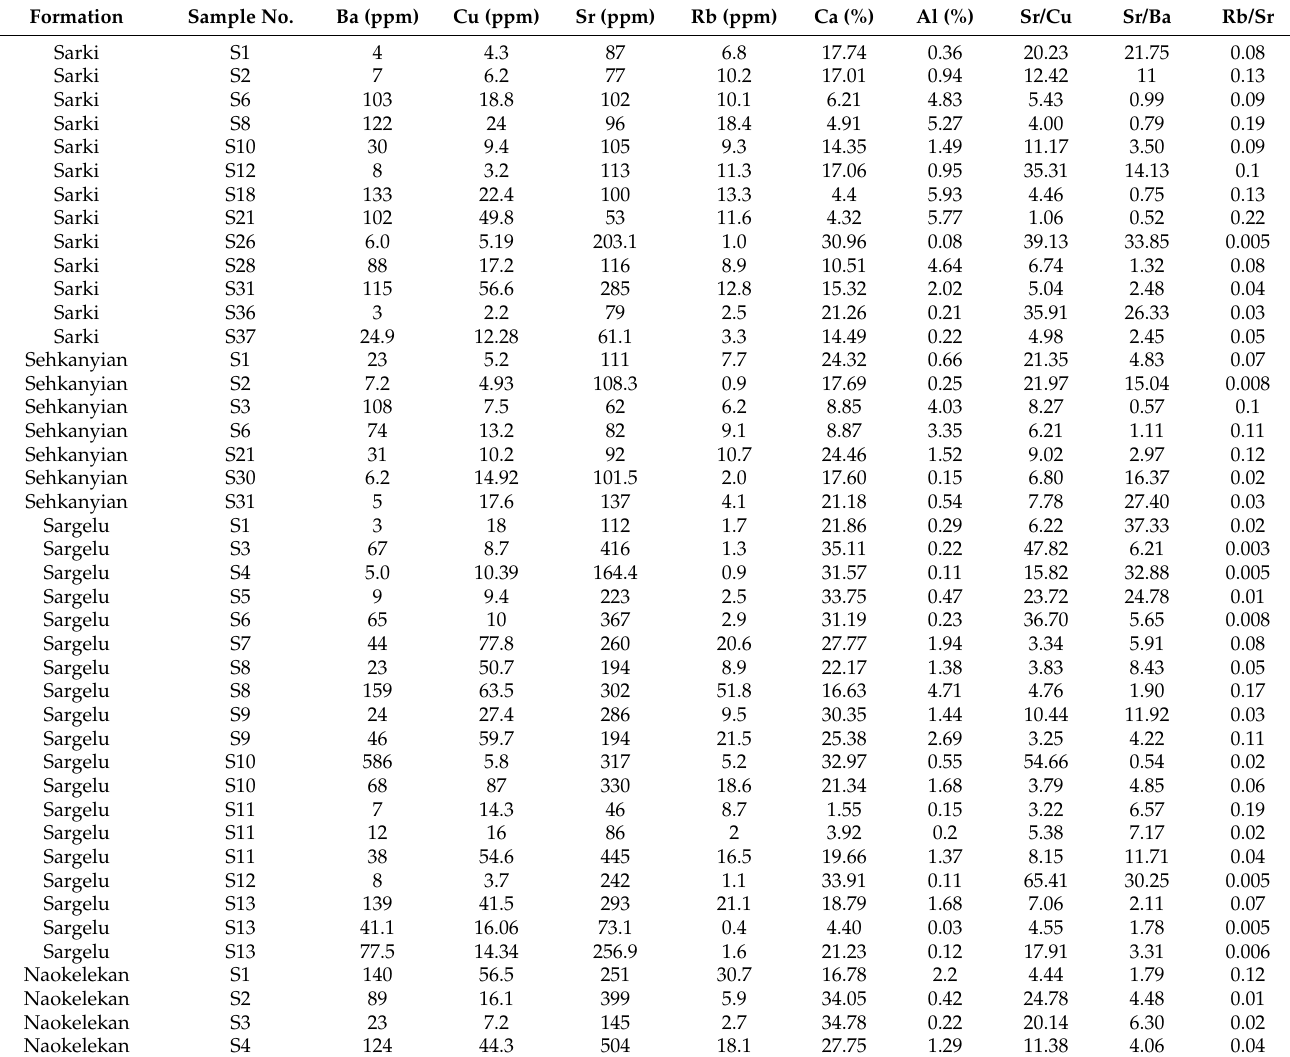
Table 3. Trace (in ppm) element concentrations, including geochemical proxies for paleoclimate conditions, Ca, Al, Sr/Ba, Rb/Sr and Sr/Cu, for the samples from the Sarki, Sehkaniyan, Sargelu, Naokelekan, Barsarin and Chia Gara